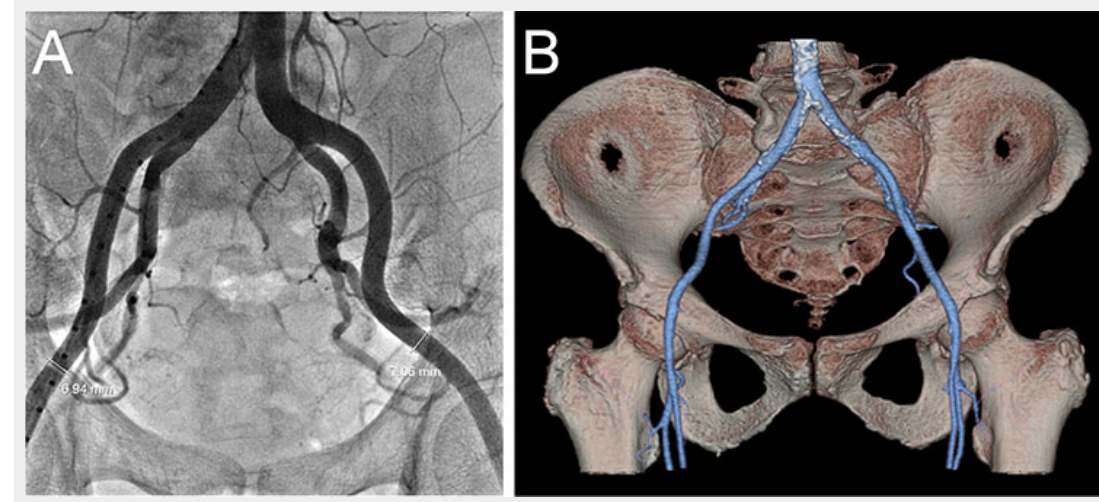
Figure 6 Screening of the iliofemoral arteries by fluoroscopy (A) and CT angiography (B).